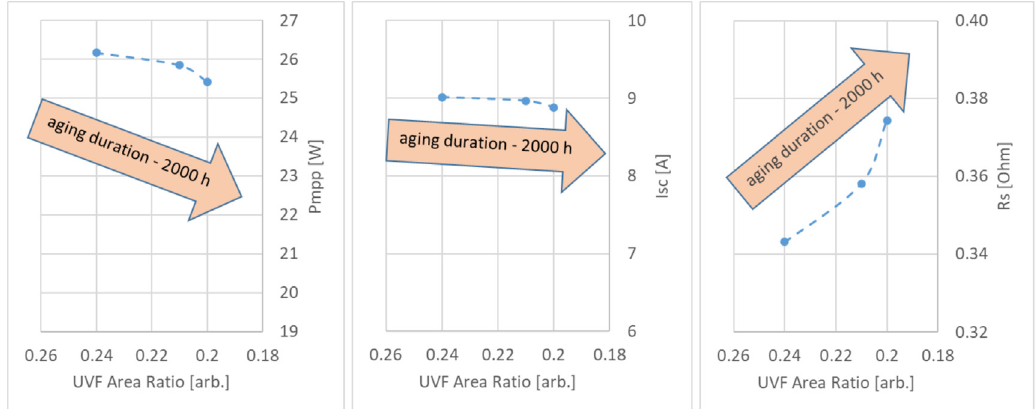
Fig. 10. Correlation of electrical parameters and UVF area ratio for Alpine 1 (85 ° C, 85% r.H., 1200 W/m 2 , 1000 cyles